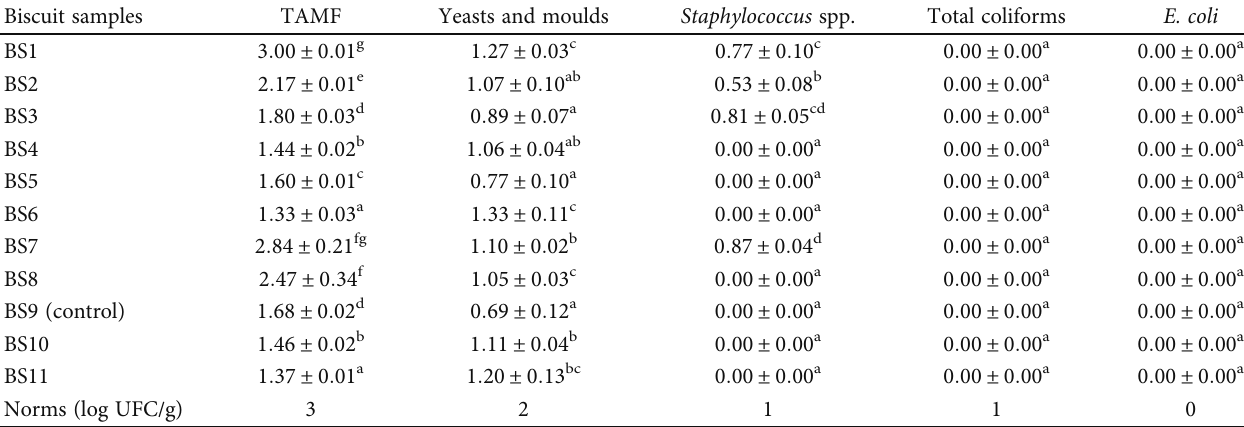
Table 4: Microbial loads (Log UFC/g) of the biscuits prepared with di ff erent proportions of fl our from fermented sweet potato. Biscuit samples